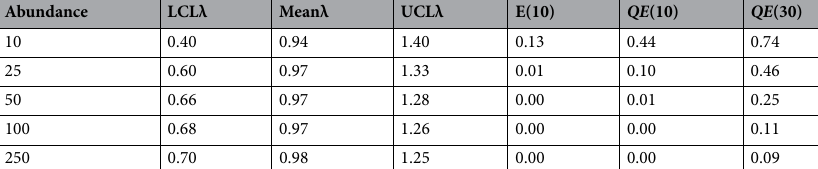
Table 3. Likelihood of population extinction (E; year 10), and quasi-extinction ( QE; mean abundance ≤ 5 adult females) at year 10 and 30 from 10,000 simulations for a population in slight decline (recruitment = 0.30; survivorship = 0.85; with λ ~